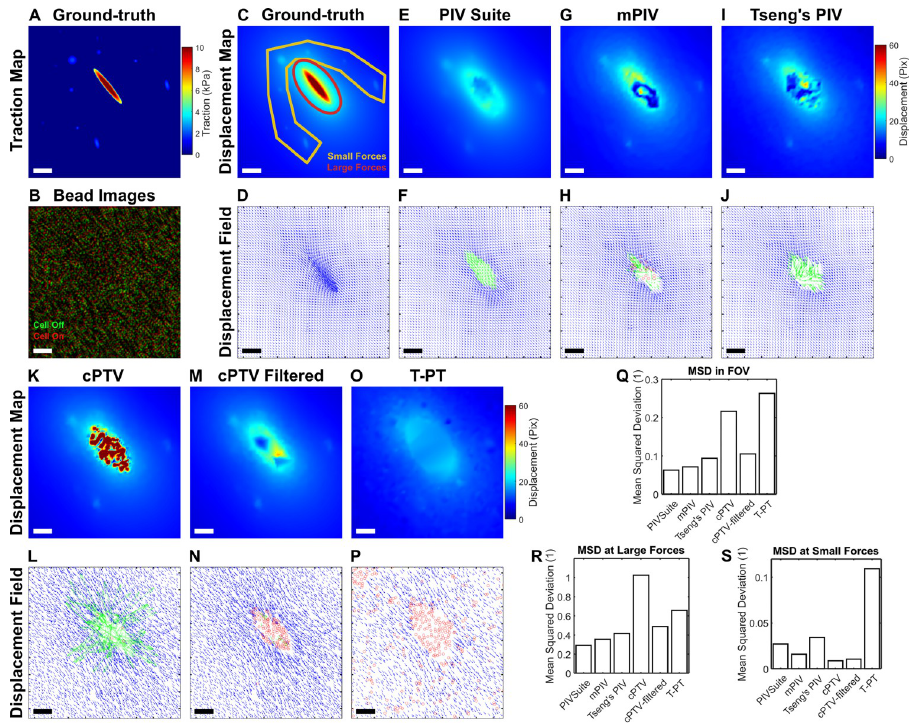
Fig 1. Typical PIV methods, a topology-based tracking and the current cPTV fail to track a large, local deformation. (A) Ground-truth traction map, designed with a large, local traction force in the center, mimicking the force from a large focal adhesion. (B) A color-merged image of a synthetic bead image (8000 beads on 512x512 pixel area) in a relaxed configuration (red) and another image of beads where displacements in A is applied (green). (C,D) Ground-truth displacement magnitude map (C) and vector field (D) calculated from the ground-truth traction distribution. Yellow polygon overlaid represents the region of displacement by the small forces whereas the red ellipse represents the region of displacements by the large force. (E-P) Displacement magnitude map (E,G,I,K,M,O) and corresponding vector field (F,H,J,L,N,P) of the pair of bead images from panel B, tracked by multiple PIV methods such as PIV Suite (E,F), Tseng’s PIV (G,H) and mpiv (I,J), a correlation-based PTV, or cPTV (K,L), cPTV where vector outliers are filtered (M,N), and a topology-based particle tracking, or T-PT method (O,P). Red circles in the vector fileds represent the seed points that have failed to track the deformation. Green arrows represent falsely-tracked vectors that show more than 10% mean-squared-deviation. Scale bars in A-P: 5 μ m assuming 108 nm/pixel. (Q-R) Bar plots of the mean-squared-deviation (MSD) for the measured displacement fields by the six tracking methods, quantified over the entire field of view (Q), large force area (R), and small force area (S).